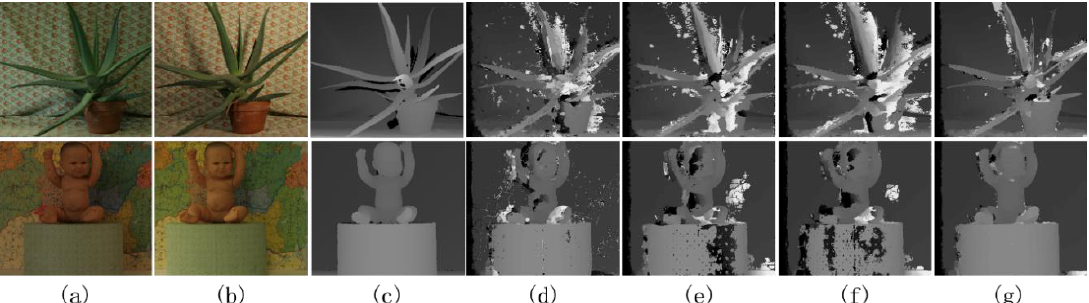
Figure 8. Disparity maps under di ff erent illumination conditions of Aloe and Baby1. ( a ) Left image under Illumination 1; ( b ) right image under Illumination 3; ( c ) ground truth; ( d ) cost combined sum of absolute di ff erence (SAD) with gradient; ( e ) cost combined absolute di ff erence (AD) with census transform; ( f ) combination of AD, gradient and census; ( g ) the proposed cost